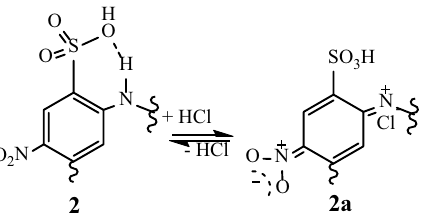
Figure 10. Proposed intramolecular interaction of the ortho-sulfonic group and the polymeric chain.